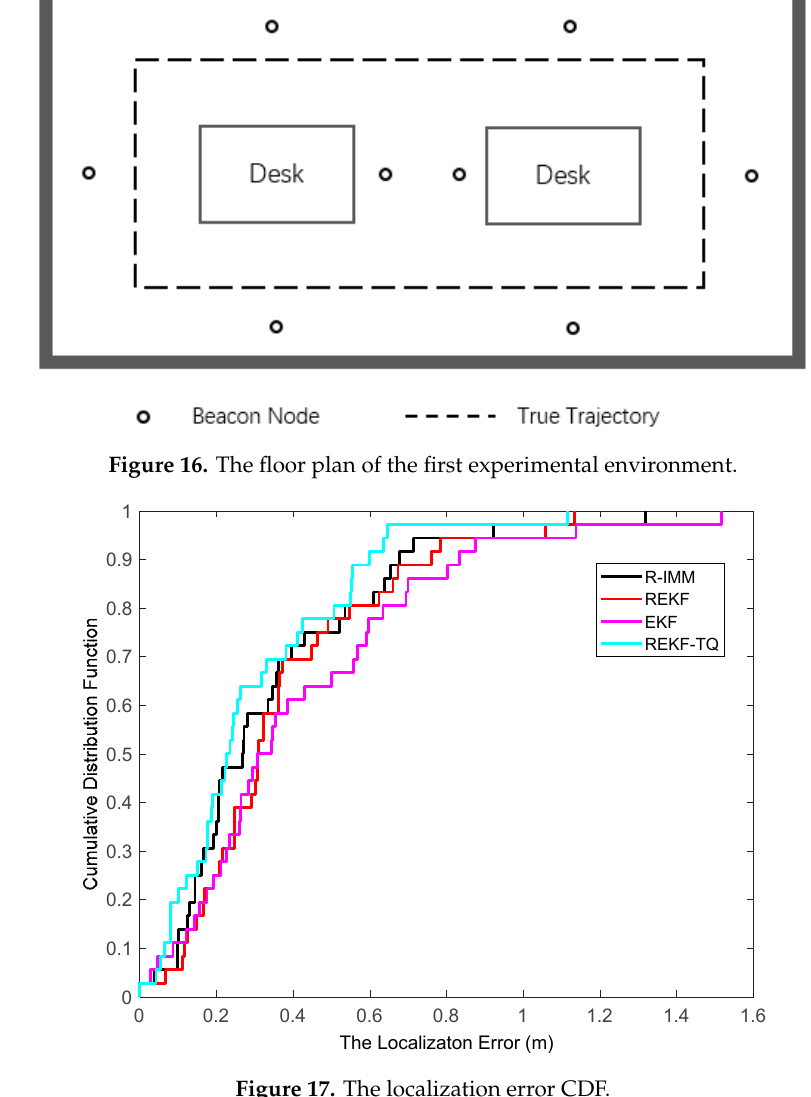
Figure 17. The localization error CDF. The second experiment is carried out under the condition that beacon nodes are randomly arranged in a 10 × 7